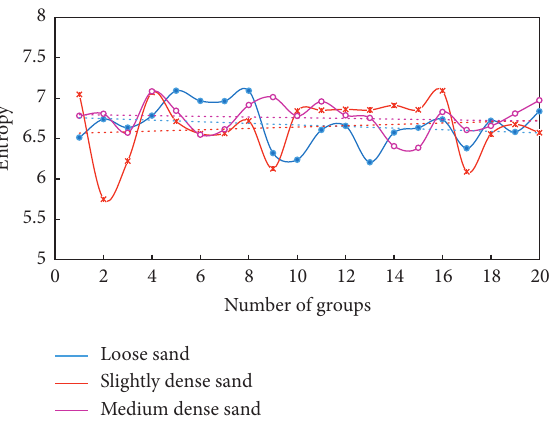
Figure 9: Variation of one-dimensional entropy of sand with different compactness.